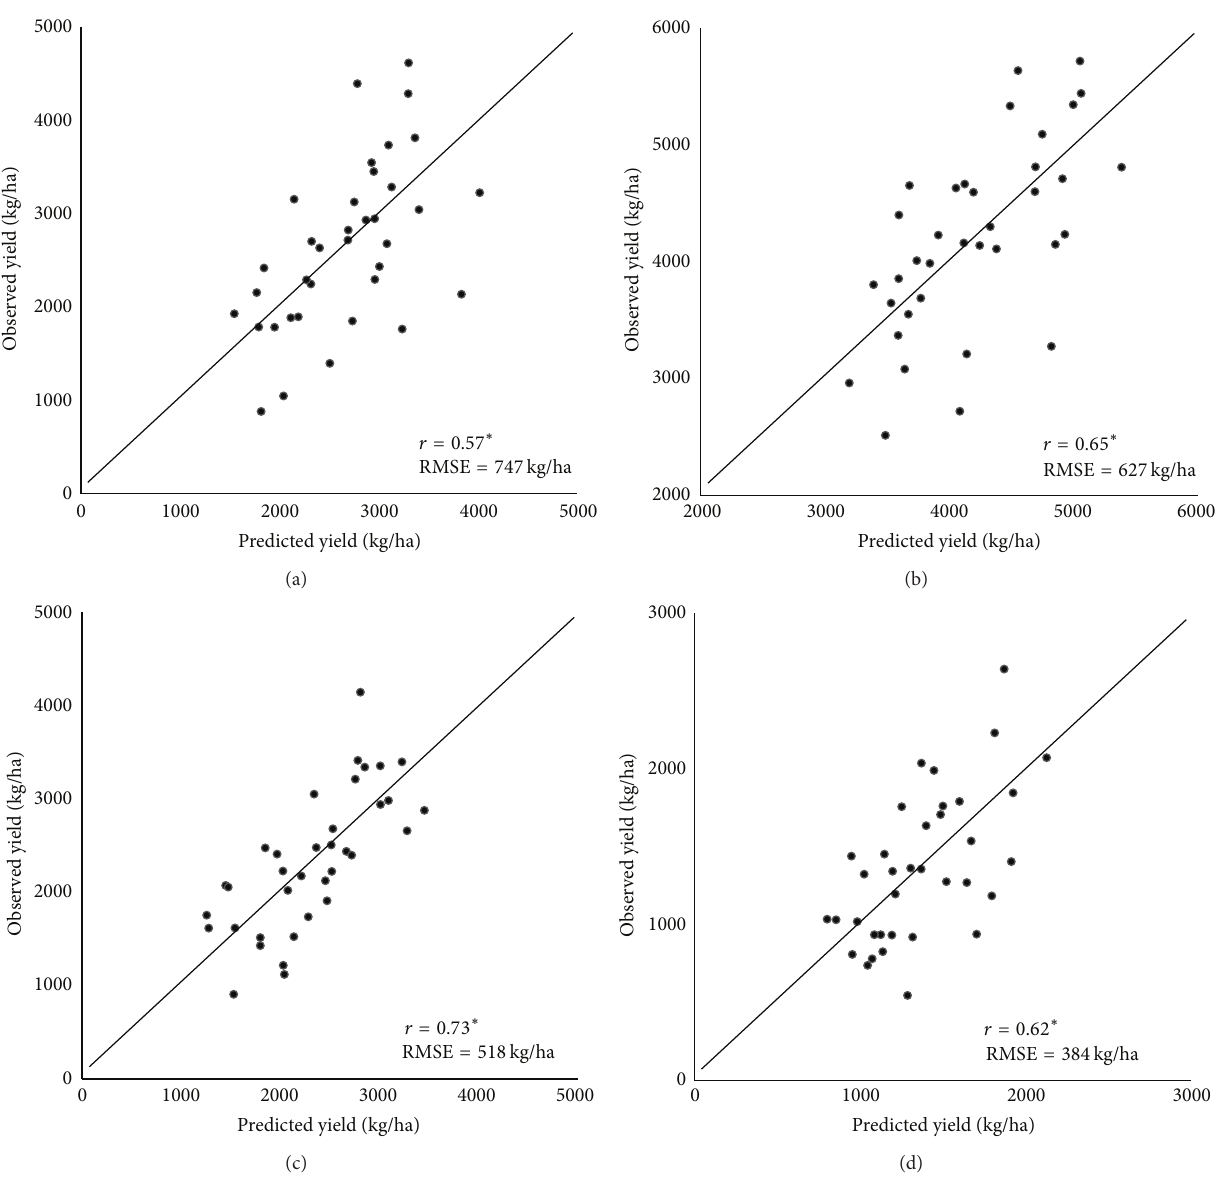
meteorological parameter based principal component regression models. Figure 1 shows observed versus predicted yields on 1 : 1 line and good agreement between observed and predicted strawberry yields can be observed. The root mean squared error (RMSE) between observed and cross-validated strawberry yield is 747 kg/ha, 627 kg/ha, 518 kg/ha, and 384 kg/ha for April, May, June, and July, respectively. These agreements between observed and predicted strawberry yields are also statistically significant at 0.05 probability level. Skills of these forecasts are higher for the month of June compared to other months. This is because higher number of meteorological parameters exhibited significant